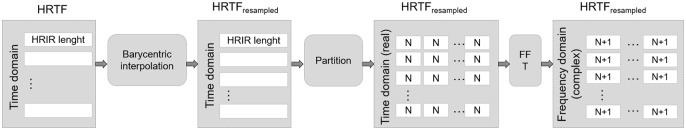
HRTF table offline process.